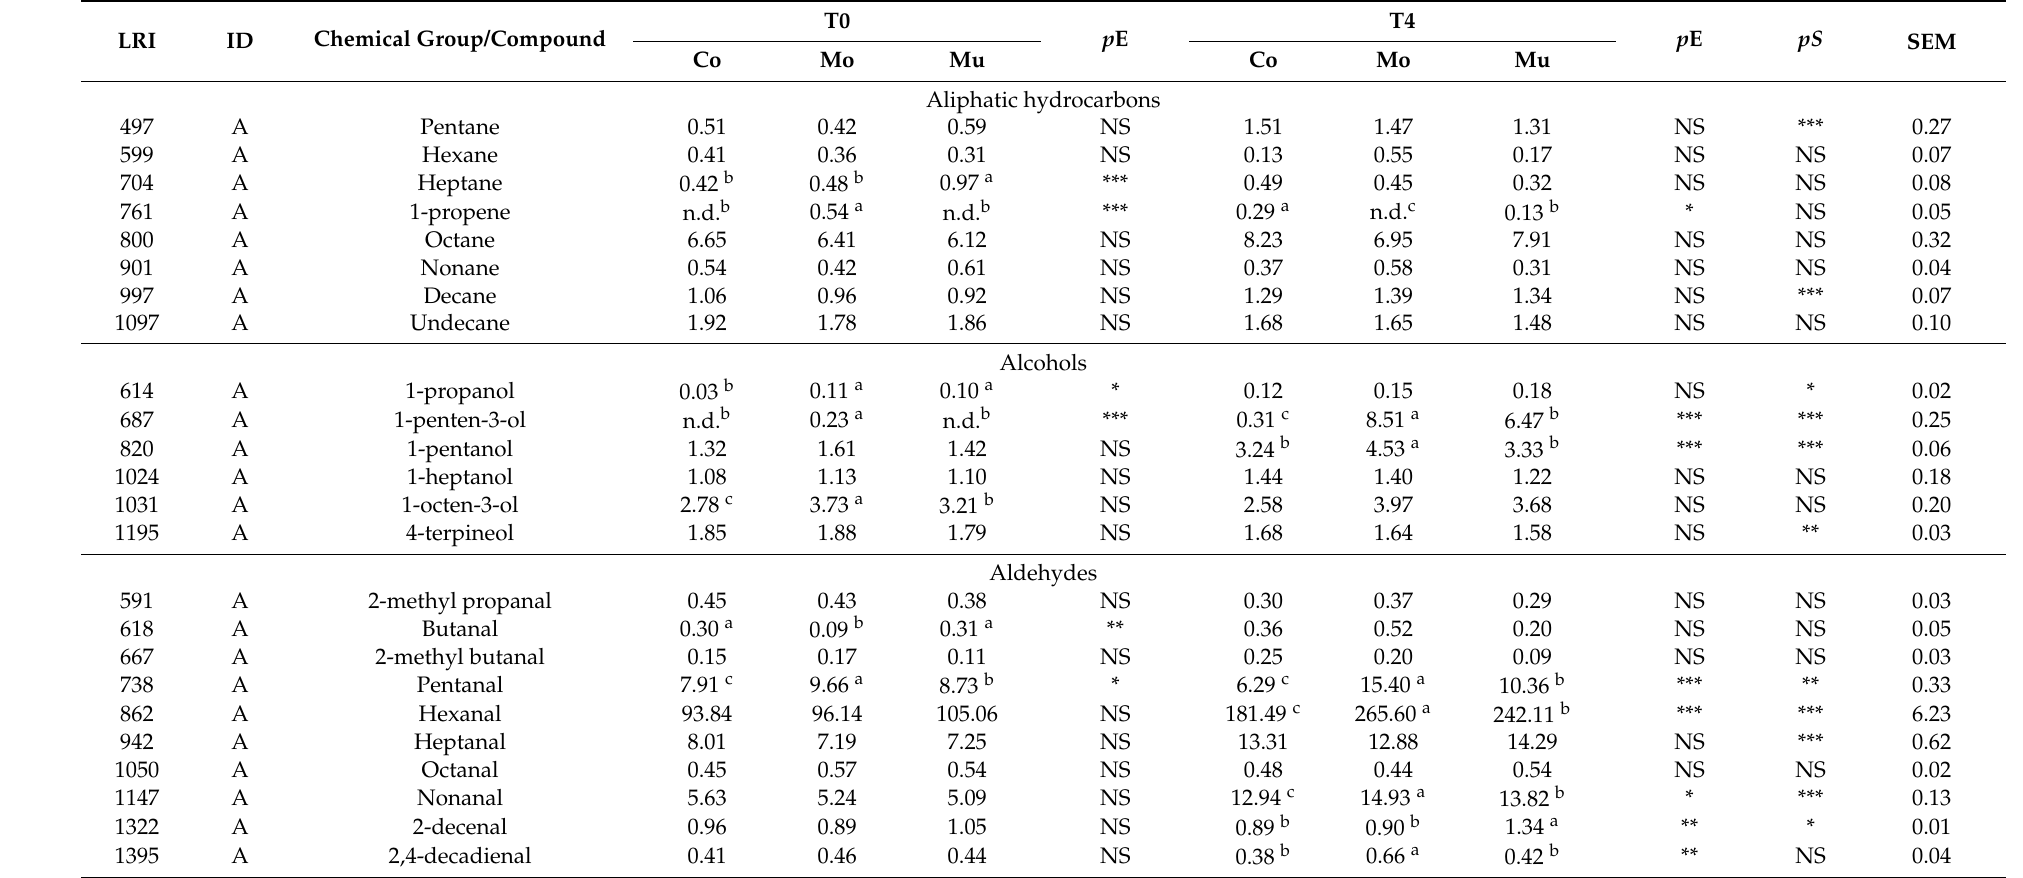
Table 1. Storage effect ( p S) on the abundance of volatile compounds (AU × 10 6 ) in omega-3-enriched dry-cured sausages ( p